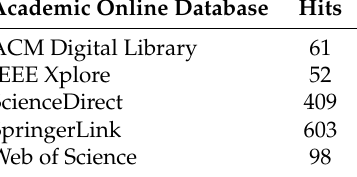
Table 1. Hits for “swarm intelligence” AND “feature selection” in online academic databases from 2007 to